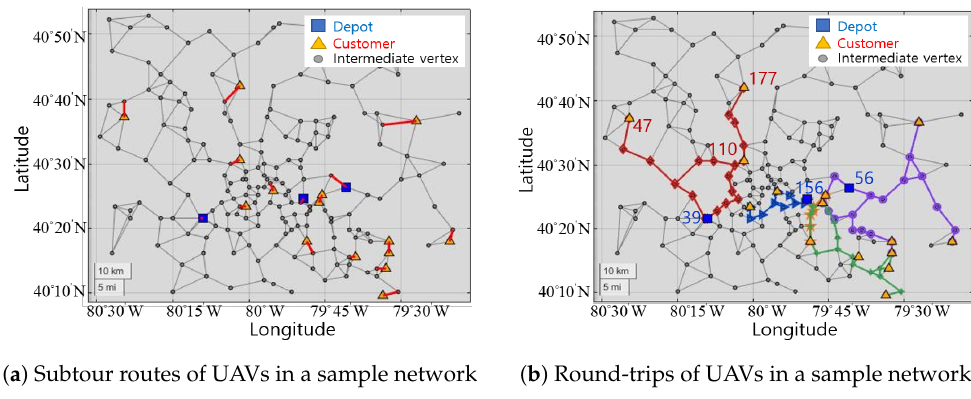
Figure 6. Subtour and round-trip routes of UAVs in a sample